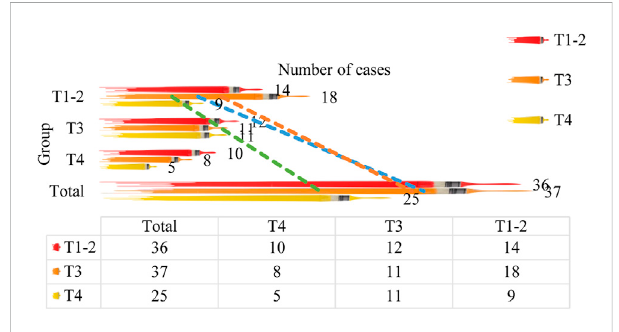
FIGURE 4 Comparison of CT staging and pathological T staging